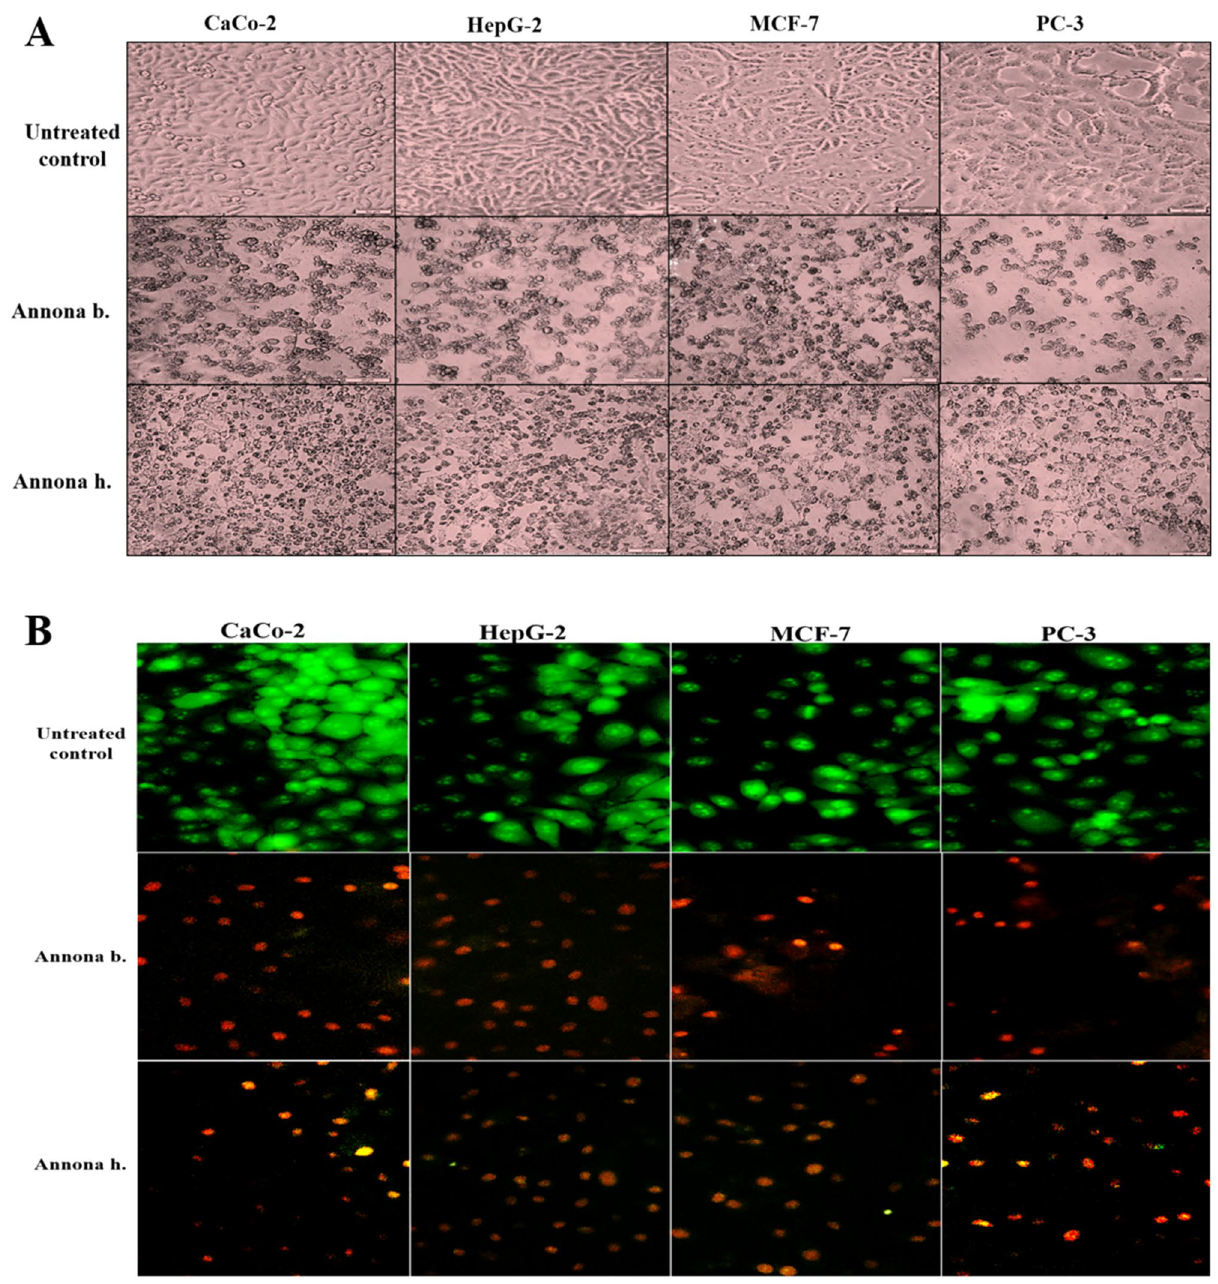
Figure 3. Morphological alterations of human cancer cell lines after treatment with the most active extract (seed) of both Annona species using ( A ) phase-contrast microscope and ( B ) fluorescence microscope after staining with ET/AO dye (green, yellow, and orange-red fluorescence nuclei refer to viable, early apoptotic, and late apoptotic cells, respectively). (CellSens Dimension 1.12; https ://www.olymp us-lifes cienc e.com/en/softw are/ cells